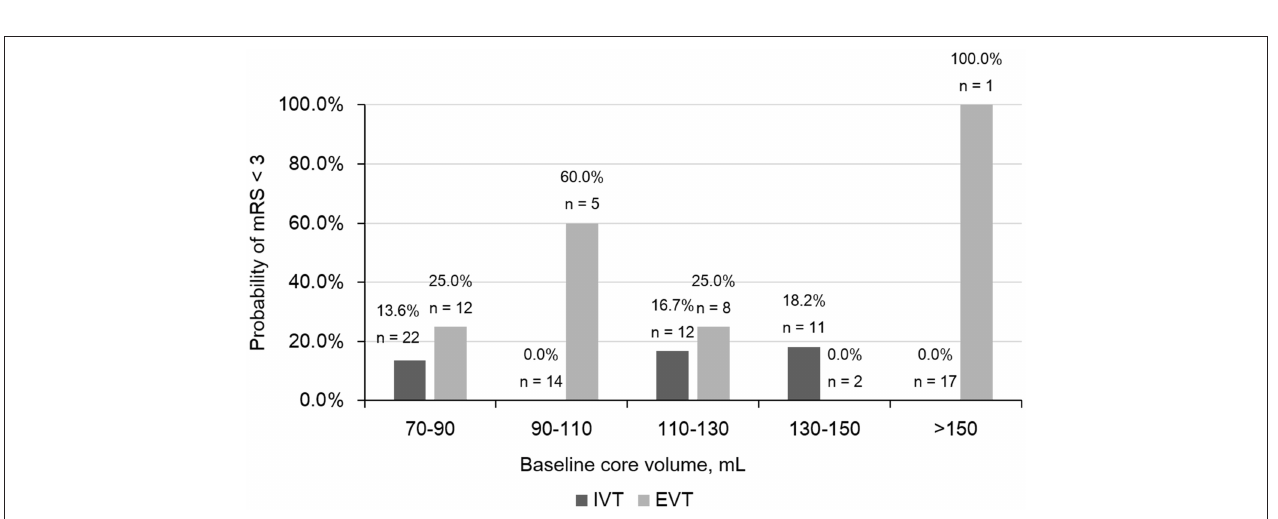
FIGURE 3 | Comparison of Probability of modified Rankin scale (mRS) < 3 in different baseline core volume subgroups. IVT, intravenous thrombolysis; EVT, endovascular treatment.